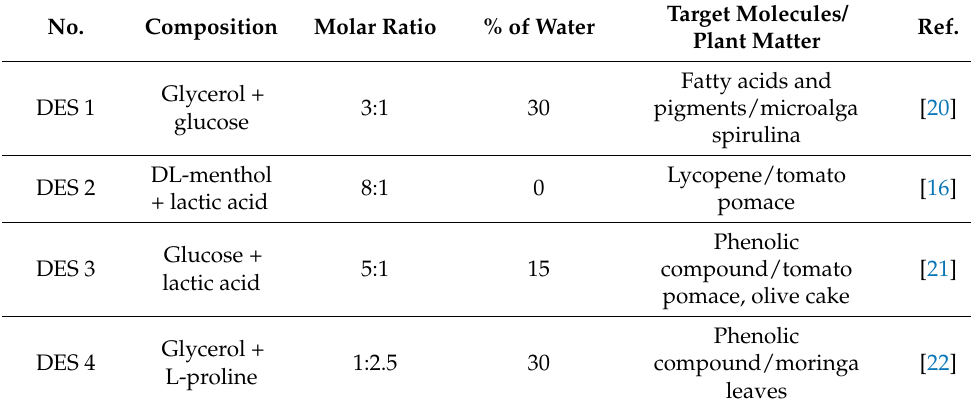
Table 1. Compositions of selected DESs.